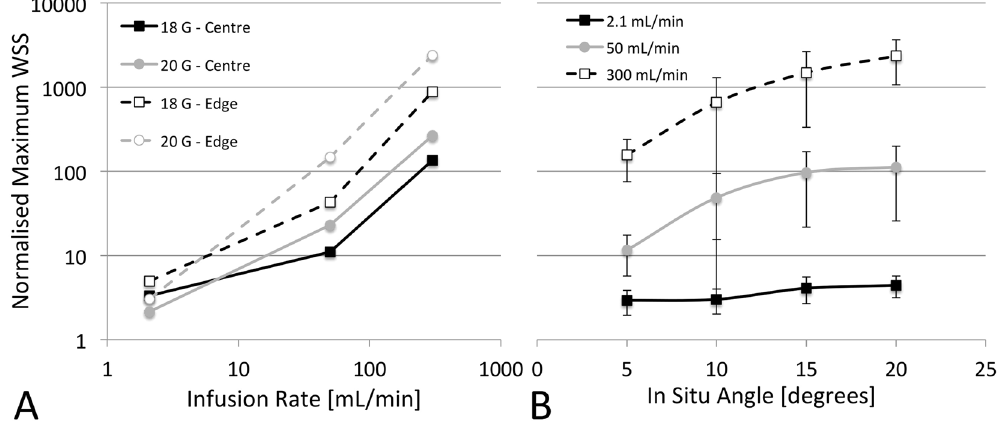
Figure 3. Effects of catheter infusion rate ( A ) and in situ angle ( B ) on wall shear stress (WSS). WSS is normalized to that of the patent vein (1.2 Pa) and presented on a log scale. Infusion rate also shown on log scale in ( A ).